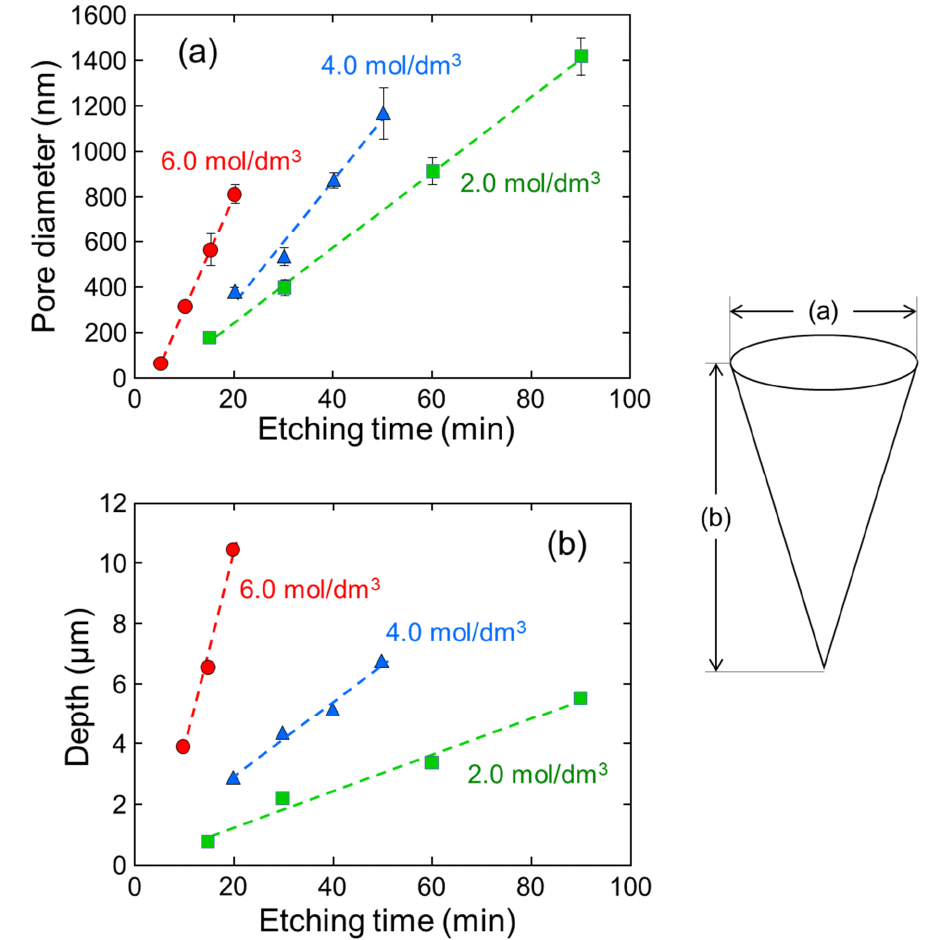
Figure 4. ( a ) Pore diameter and ( b ) depth as a function of the etching time in an aqueous NaOH solution with different concentrations at 60 ° C. Figure 5 depicts the aspect ratio (AR) [17] and the cone angle, α, [18] of the conical pores, which are defined as the ratio of the depth to the surface diameter and the angle between two generatrix lines, respectively. Based on the assumption of a perfect conical geometry, the α values were calculated by the relationship α = 2tan −1 (1/AR). For example, these were estimated to be 6.8 and 8.4 ° , respectively, for the pores shown in Figure 3. For all of the etching times, we observed their average values change from 4.3 to 12.2 and from 13.3° to 4.7°, respectively, with the increase of the concentration of the aqueous NaOH